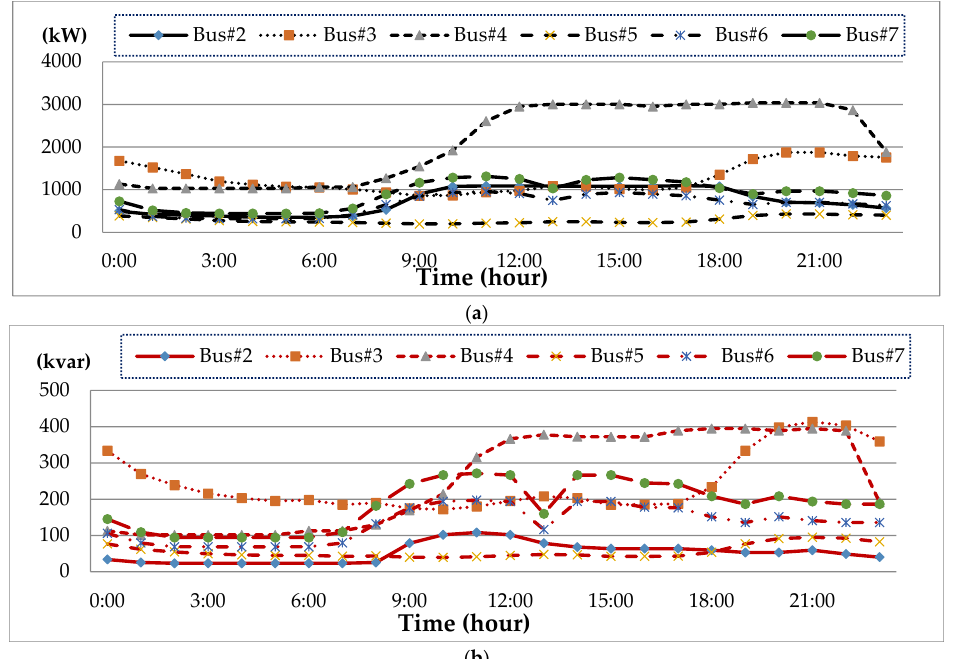
Figure 7. Daily load curve of MG-A, ( a ) real power; ( b ) reactive power.